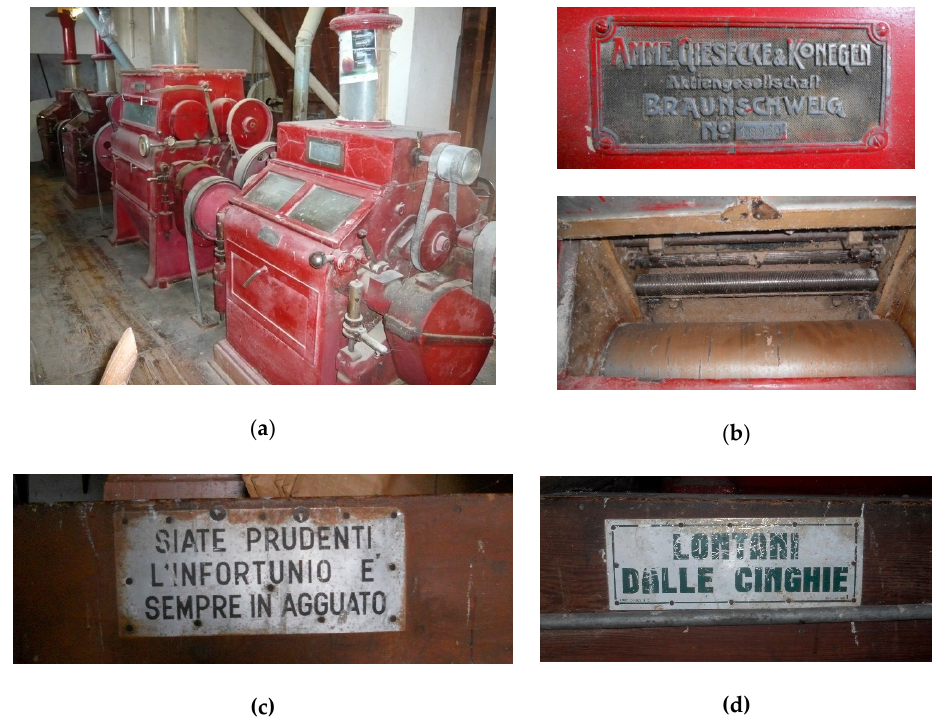
Figure 14. The Forno mill: ( a ) Amme Giesecke & Konegen roller mills; ( b ) particular of the label and inside of the mill; ( c ) and ( d ) old accident prevention signs: “Be prudent; the injury is always lurking” and “Far from the belts”.